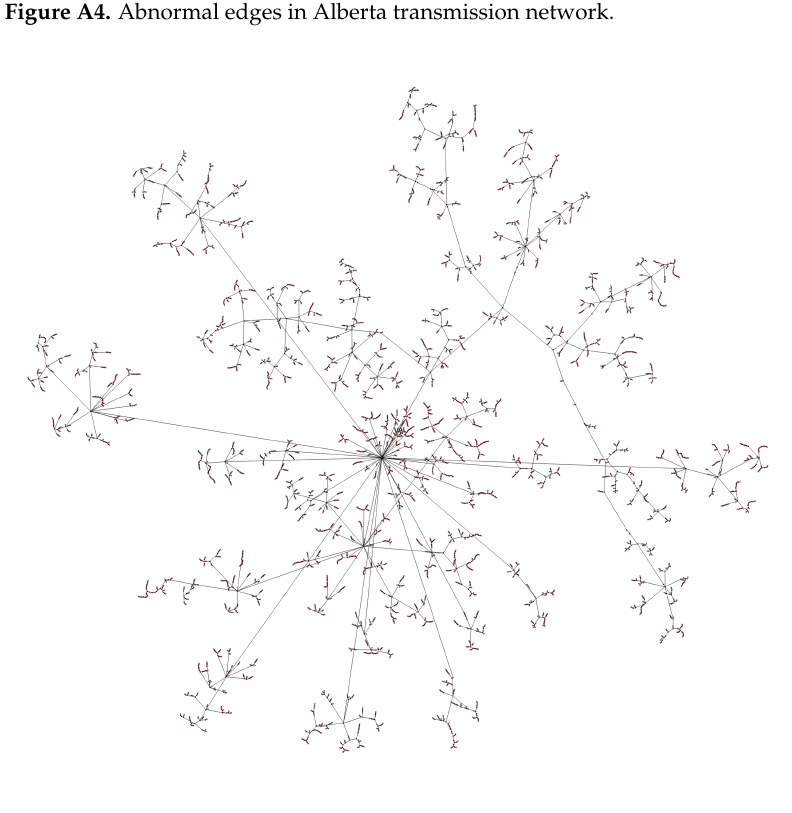
Figure A5. The inferred New York State transmission